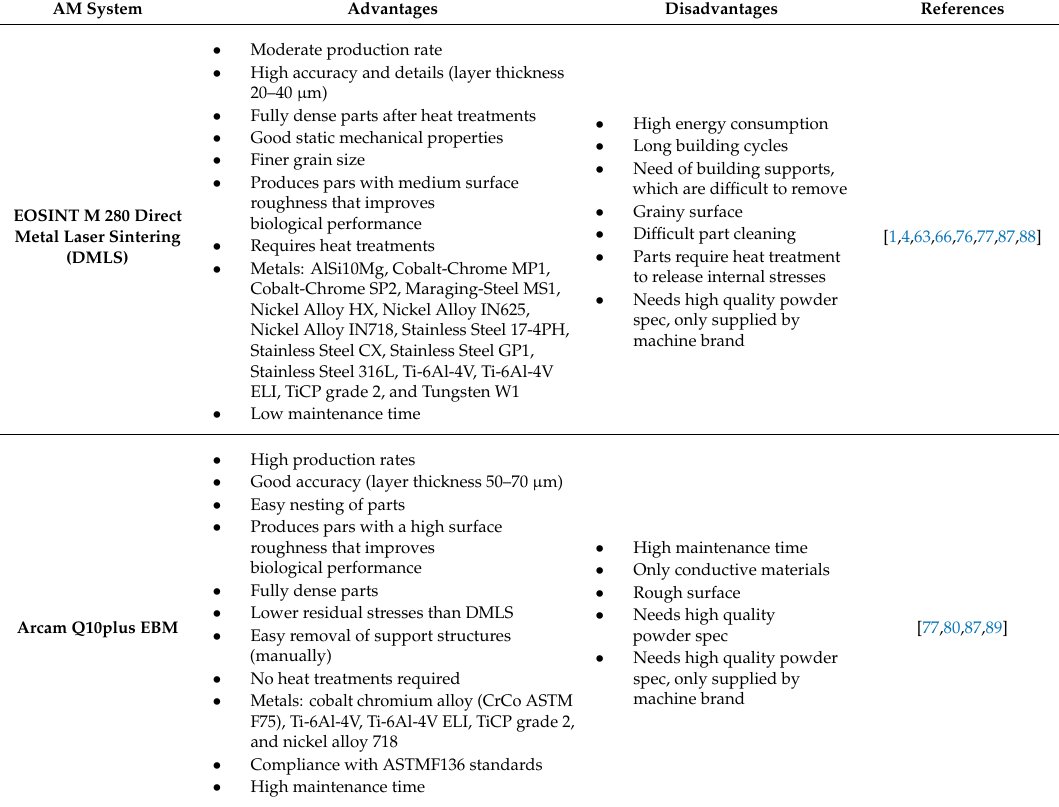
Table 5. Advantages and disadvantages of the AM machines for production of metallic parts used by the studied